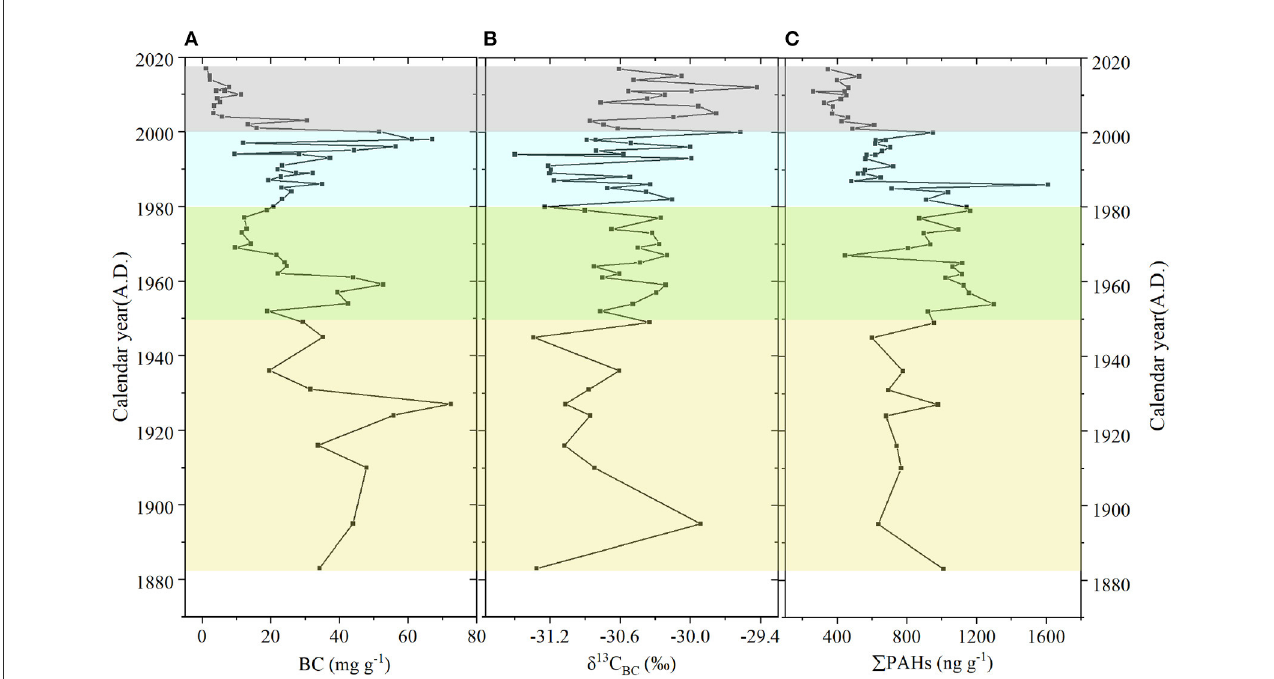
FIGURE4 The contents of BC (A) , δ 13 C BC (B) , ratios, and the total PAHs content (C) , in the core of